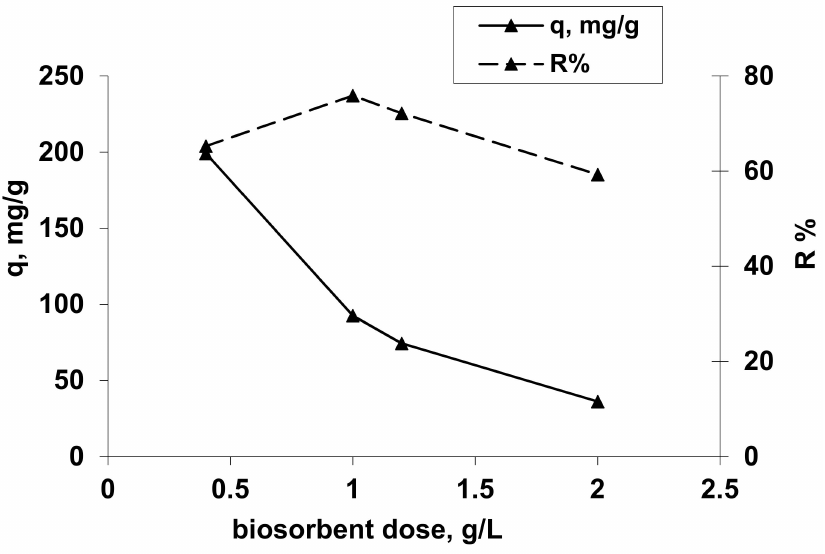
Figure 4. Influence of biosorbent concentration on Co 2+ uptake. Operational